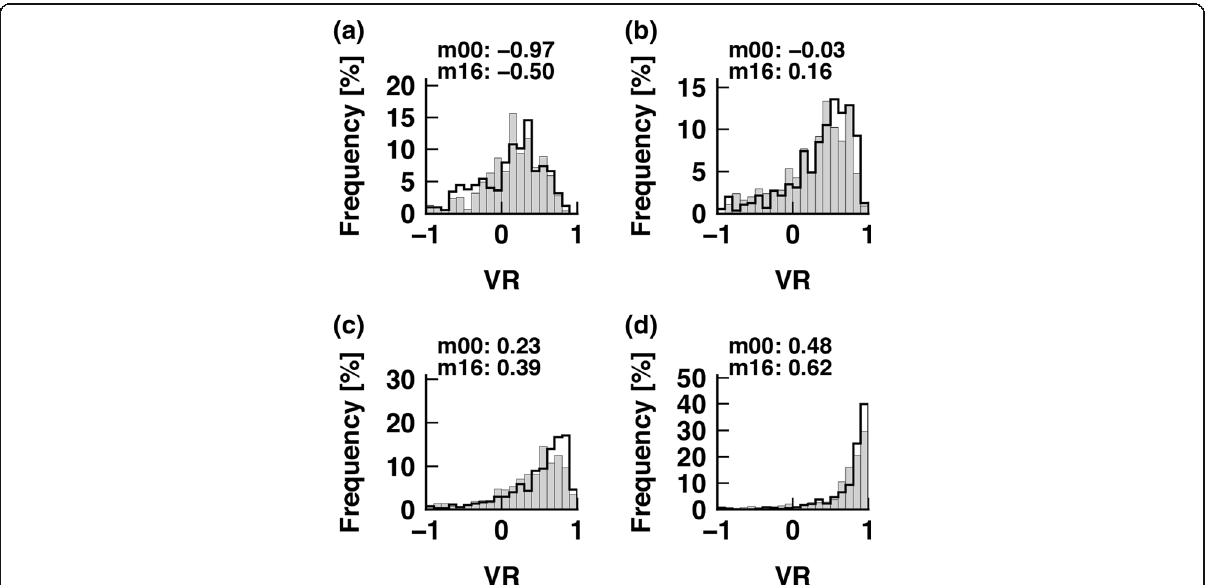
Fig. 13 Waveform fitting for extra events. a 5 – 30 s, b 8 – 30 s, c 10 – 30 s, and d 20 – 30 s. The gray bars and black outlines indicate the VR values of m 00 and m 16 , respectively. The average VR values are also shown in each